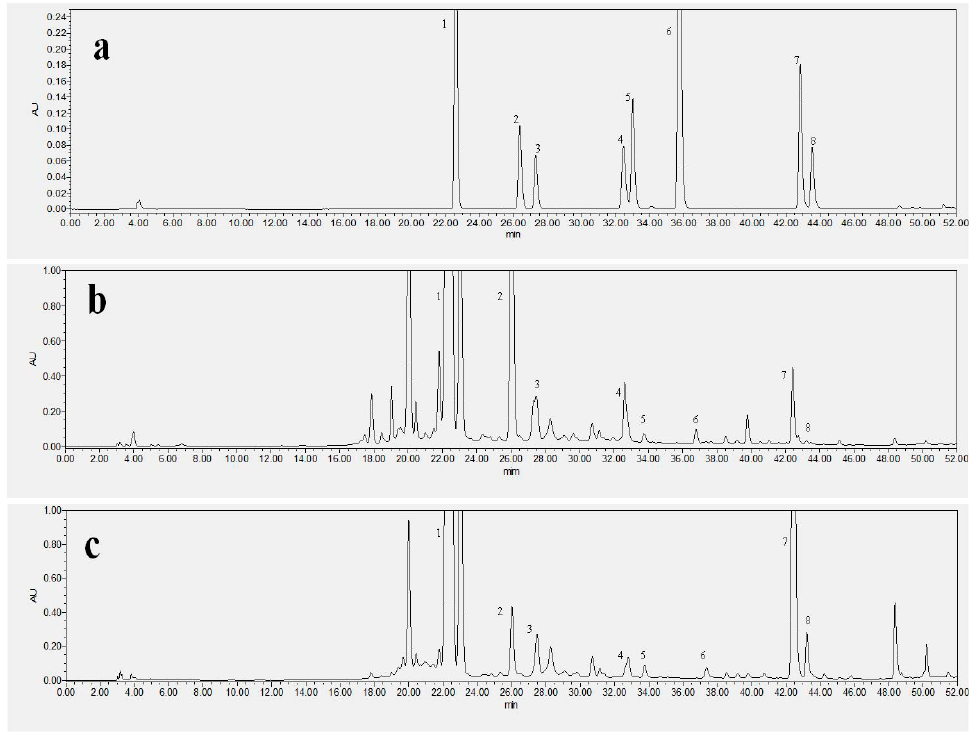
Figure 1. Reversed-phase high performance liquid chromatography (RP-HPLC) chromatogram analyzed the isoflavones of seven standard, non-fermented kudzu root (NFK), fermented kudzu root (FK). ( a ) including (1) Puerarin; (2) Daidzin; (3) Glycitin; (4) Genistin; (5) Ferulic acid; (6) Daidzein; (7) Glycitein; (8) Genistein; ( b ) NFK; ( c ) FK. Table 1. Special isoflavonoid compounds of NFK and FK. The results are expressed as µg/g. DW. Special Compounds NFK FK